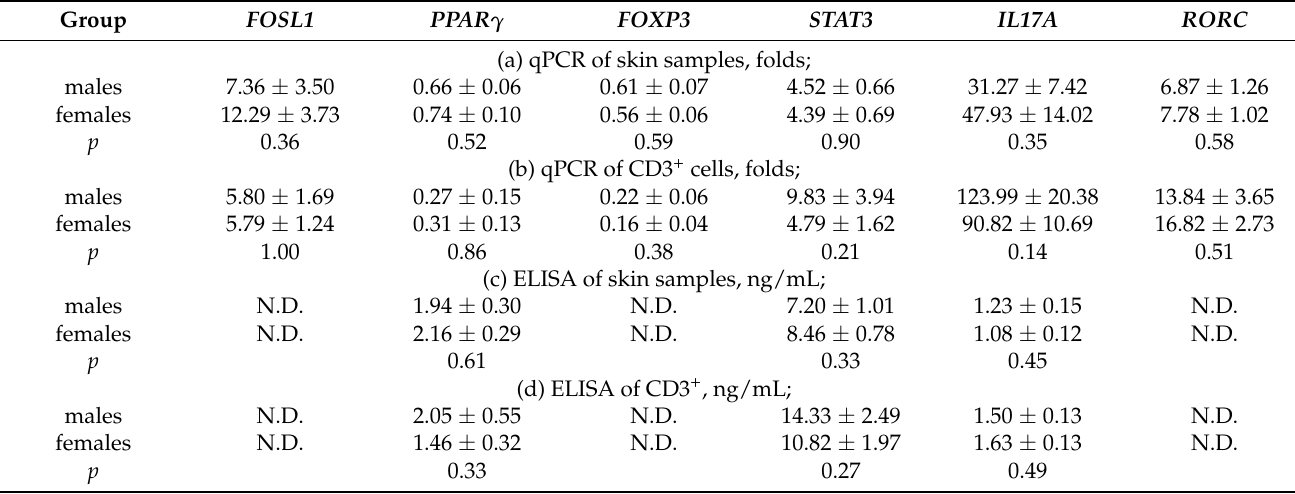
Table 2. Comparative analysis of gene and protein expression in male ( n = 10) and female ( n = 13) patients. Group